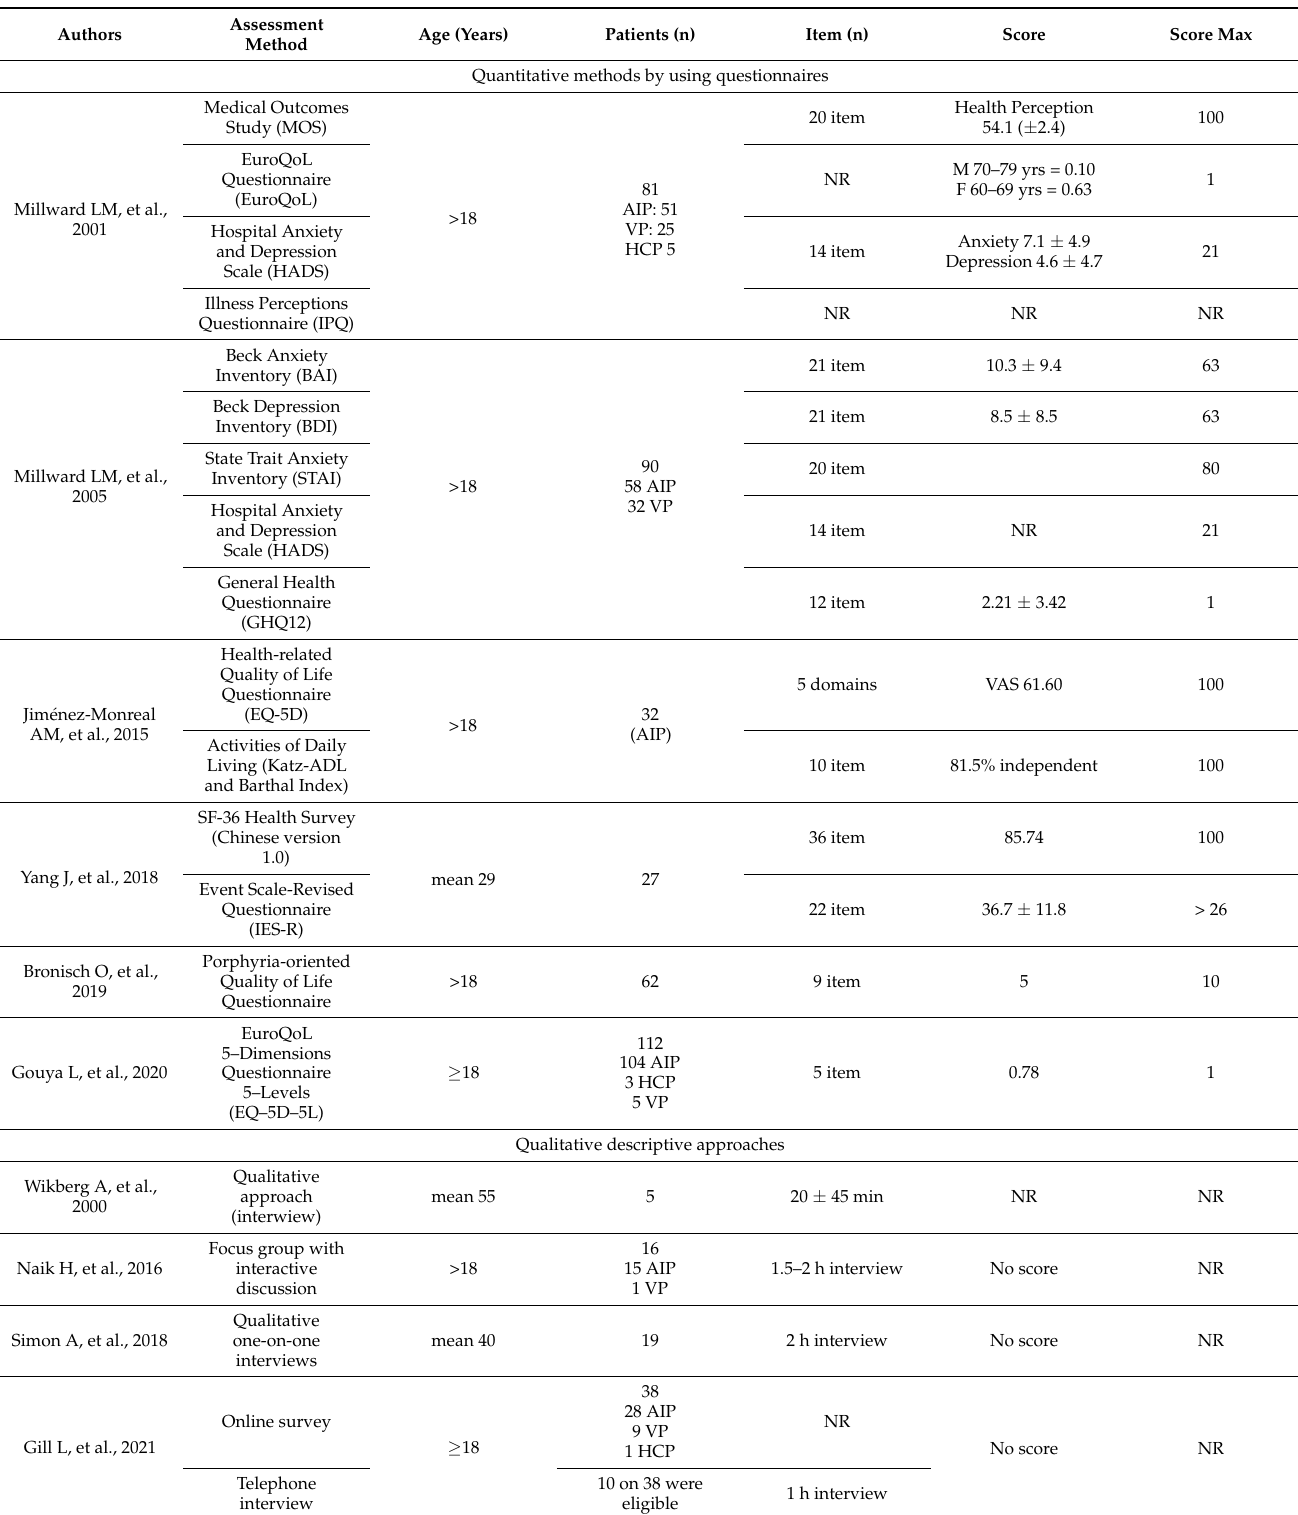
Table 1. The sum-up of literature of AHPs: author; methodology; age; number of screened patients; number of the item; significative score; the maximum score. NR = not